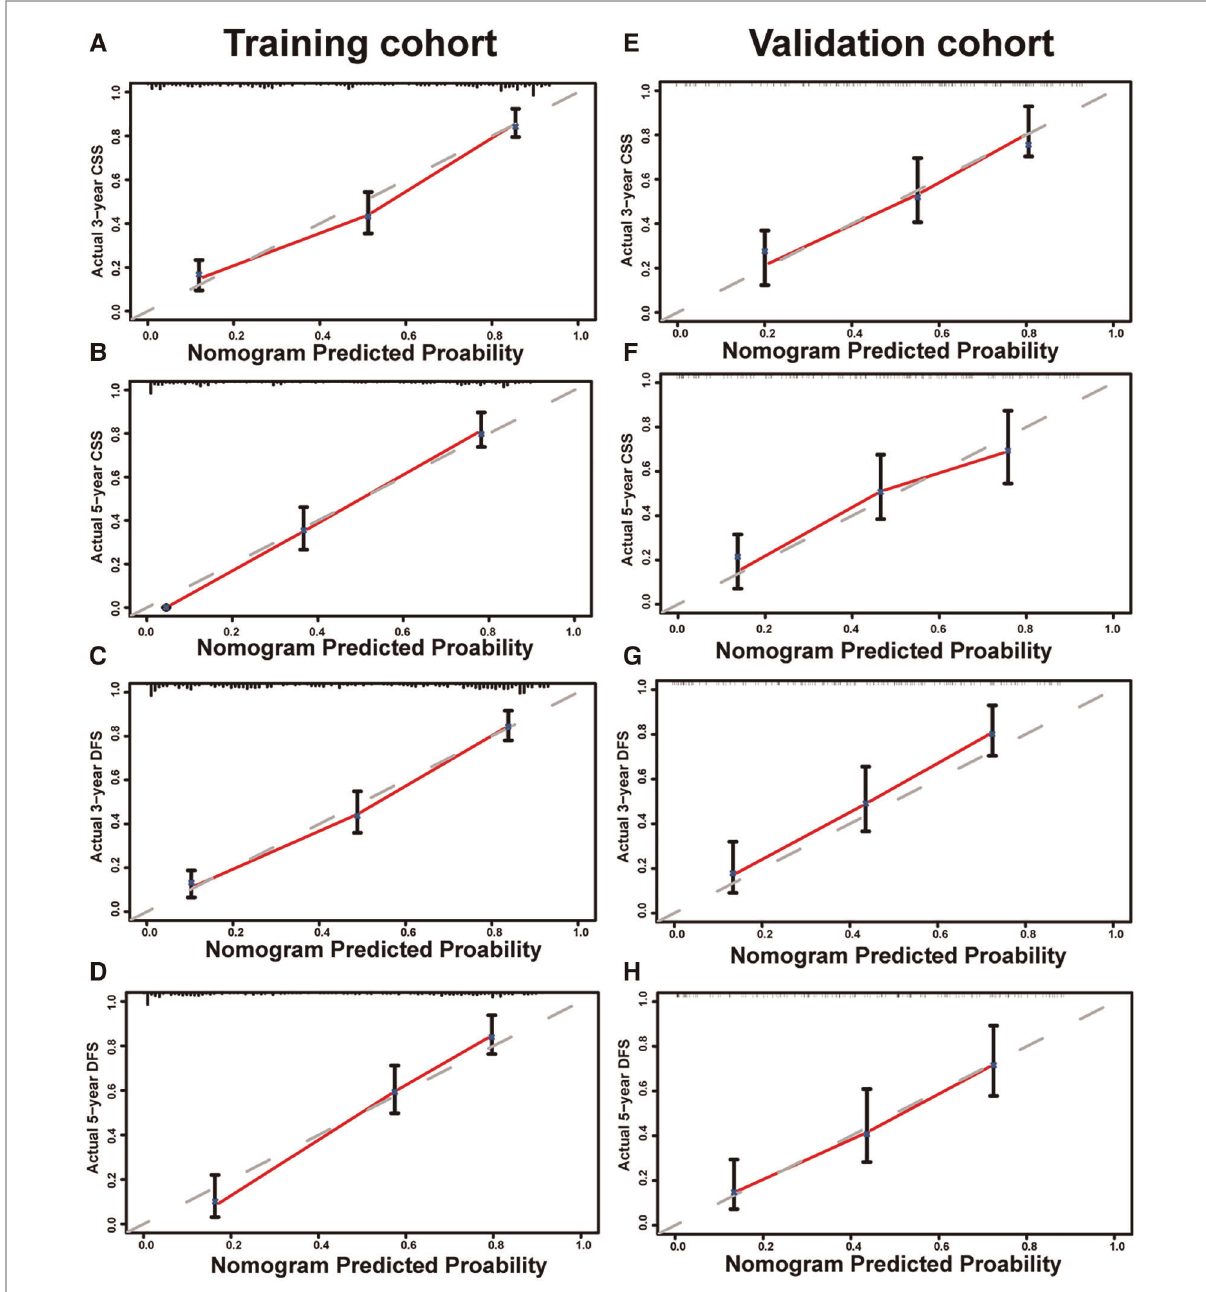
FIGURE 2 Calibration curves of nomogram for predicting 3-year cancer-speci fi c survival (CSS) ( A ), 5-year CSS ( B ), 3-year disease-free survival (DFS) ( C ), and 5- year DFS ( D ) in the training set. Calibration curves of nomogram for predicting 3-year CSS ( E ), 5-year CSS ( F ), 3-year DFS ( G ), and 5-year DFS ( H ) in the validation